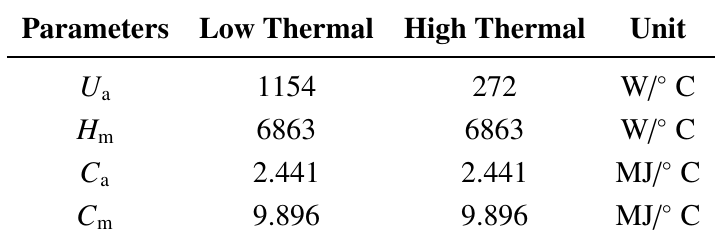
Table A1. Lumped parameters.